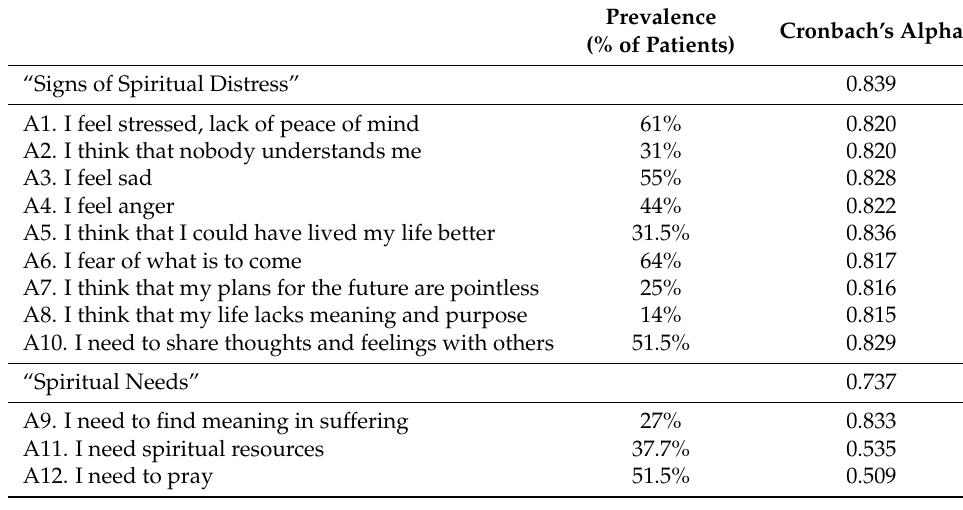
Table 2. Factor analysis.